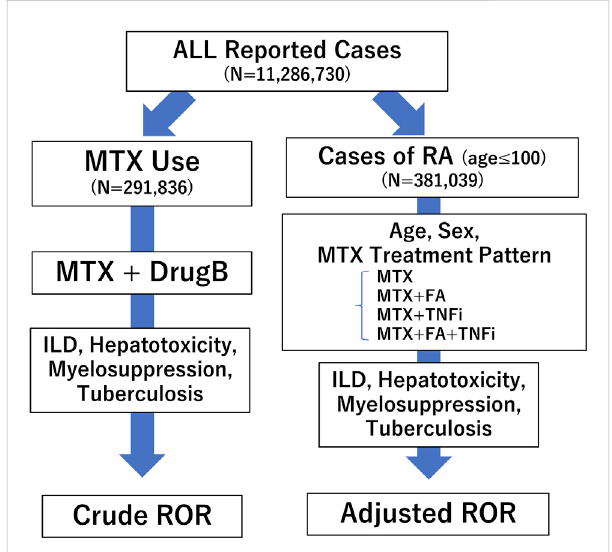
FIGURE 1 Flow chart for determining crude reporting odds ratios (cRORs) and adjusted RORs (aRORs) of methotrexate (MTX)-related adverse events. A disproportionality analysis was performed focusing on MTX useandrespectiveadverseeventssuchasinterstitiallungdisease (ILD), hepatotoxicity, myelosuppression, and tuberculosis (TB), considering all reported cases. Next, we selected patients with rheumatoid arthritis (RA) who were ≤ 100 years old and conducted a multiplelogisticregressionanalysis tocalculateaRORs fortheadverse events. We set each adverse event as the objective variable and age, sex, and treatment patterns of MTX as explanatory variables. RORs, reportingoddsratios;MTX,methotrexate;ILD,interstitiallungdisease; RA, rheumatoid arthritis; FA, folic acid; TNFi, tumor necrosis factor